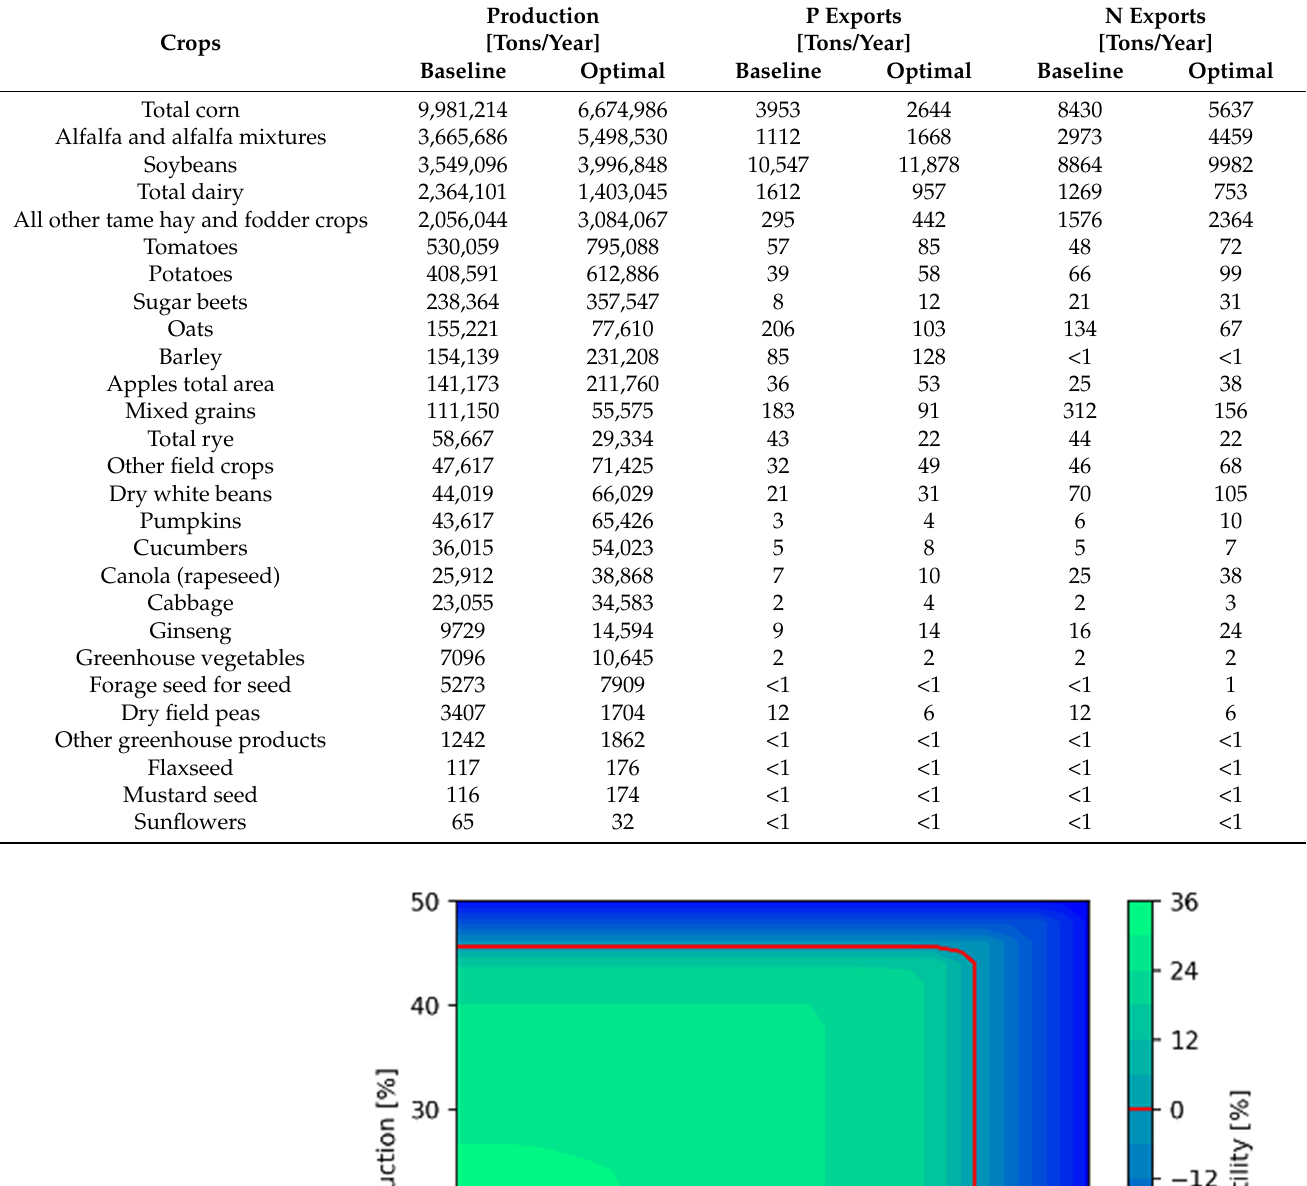
Table 4. Crop production, P and N exports for the baseline and the optimum solution, allowing the same total maximum export of P and N as in the baseline.